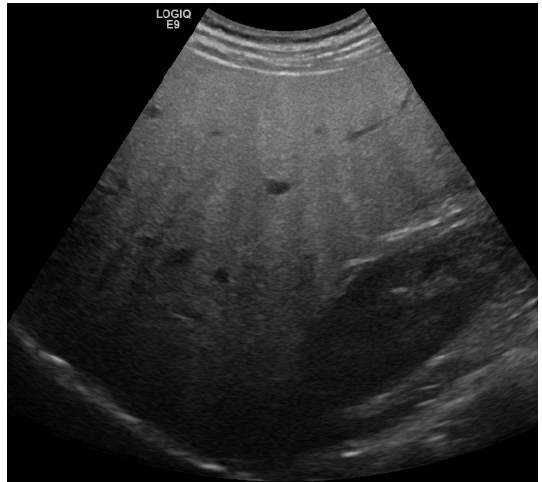
Figure 1. B-Mode sonography with marked increase in fine echoes with poor or non-visualization of the intrahepatic vessel borders, diaphragm, and posterior right lobe of the liver. This finding is pathognomonic for steatosis.